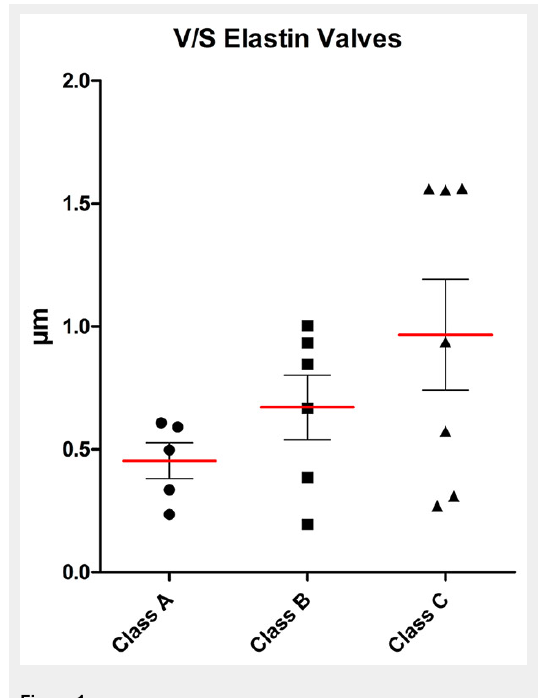
Volume-to-surface ratio of the elastin content of valves for the three classes (mean (red line), standard deviation and individual